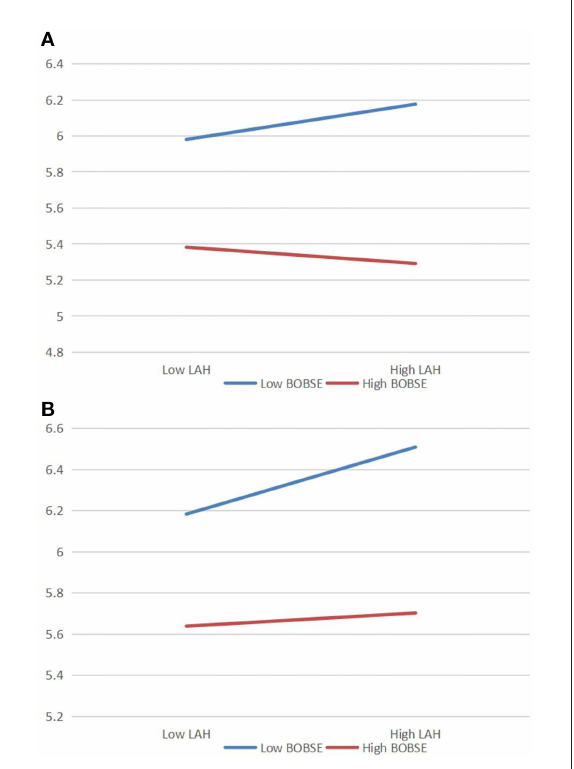
FIGURE3 Moderation effect of bystander organization-based self-esteem between leader aggressive humor and bystander affective rumination (A) . Moderation effect of bystander organization-based self-esteem between leader aggressive humor and bystander workplace anxiety (B) . N = 443;